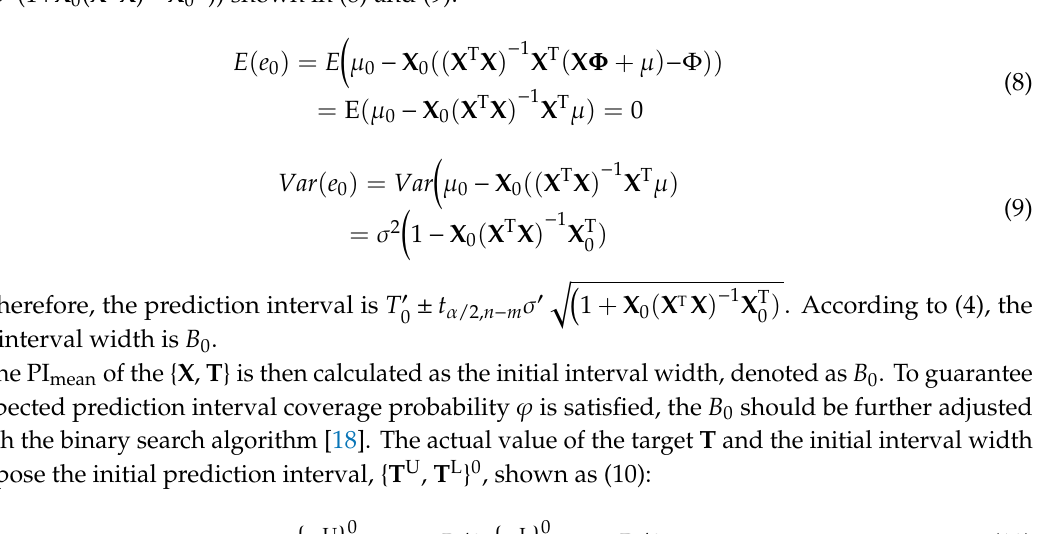
Algorithm 1: Prediction Interval Width Initialization.